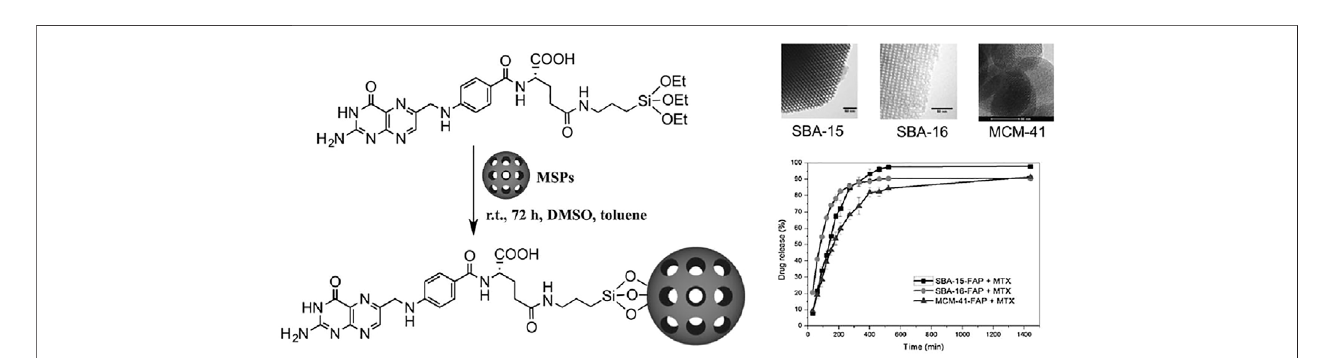
FIGURE 4 | Loading of folic acid into SBA-15/NH 2